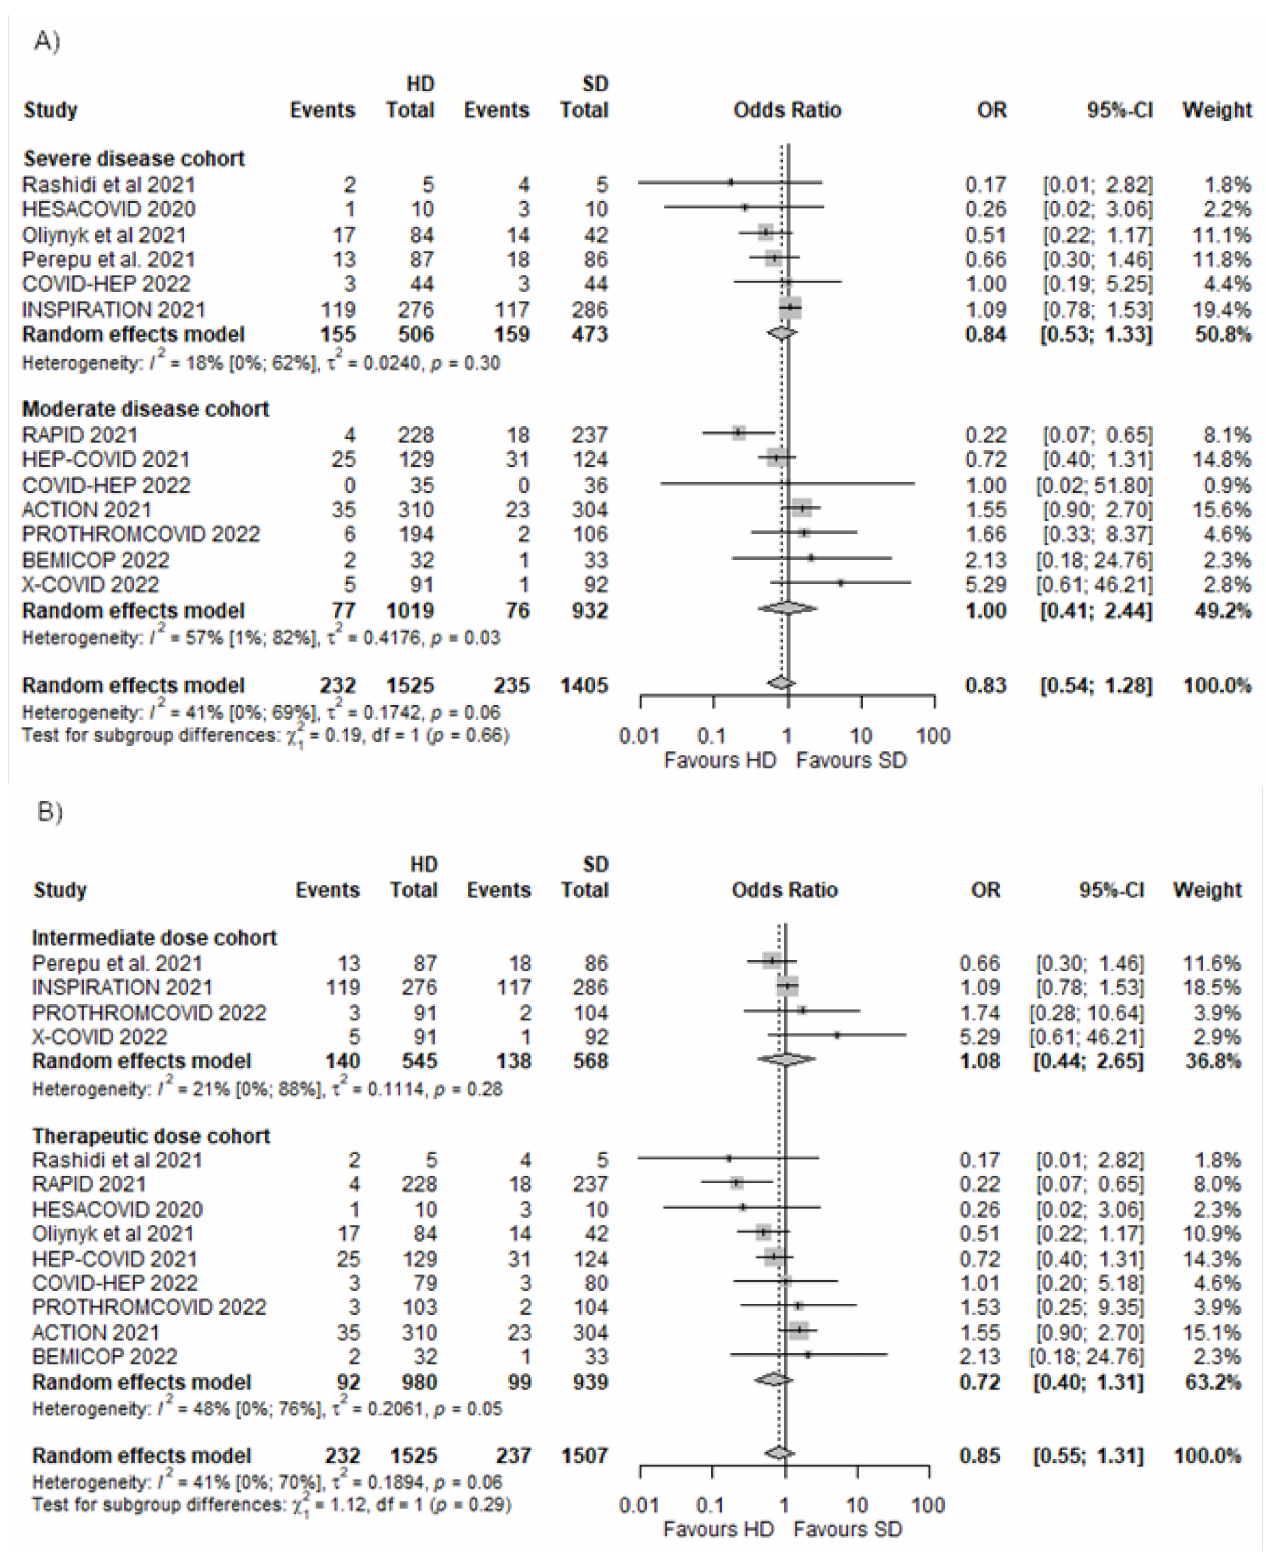
Figure 2. All-cause mortality in different dosing regimens in moderate and severe disease co- horts [19,21–25,50,52–56]. ( A ) All-cause mortality in severe and moderate disease cohorts; ( B ) all- cause mortality in cohorts where intermediate or therapeutic dose was used in the HD